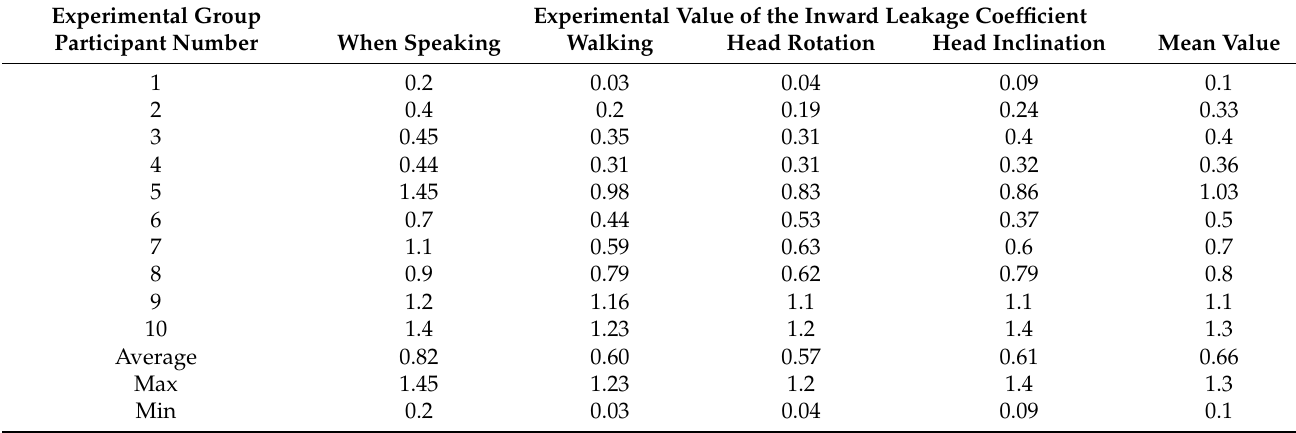
Table 5. The experimental value of the inward leakage coefficient when testing the prototype FDR models. Experimental Group Participant Number